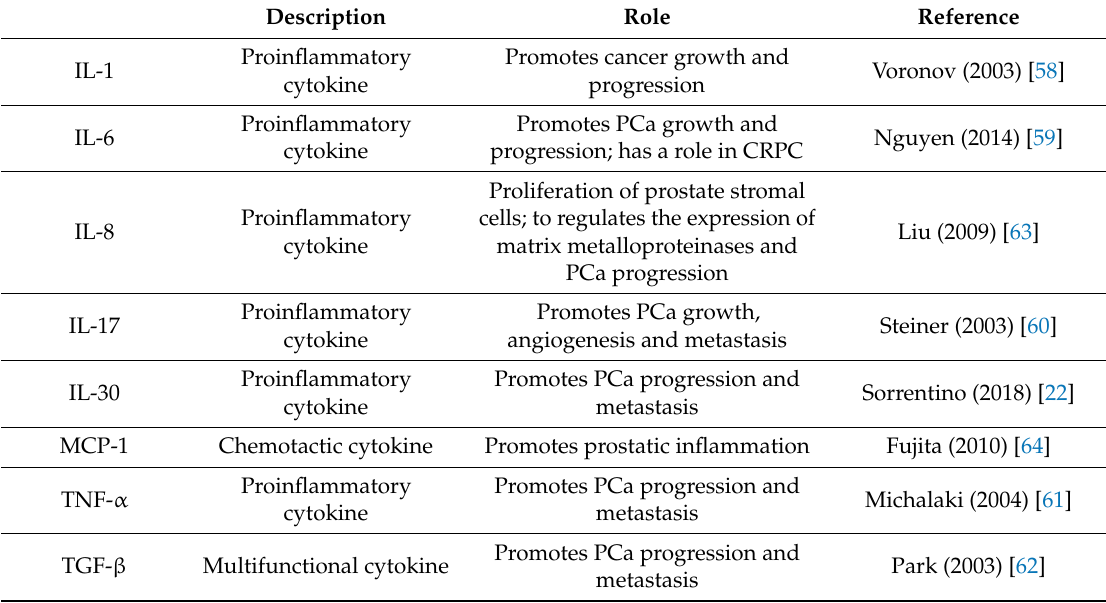
Table 1. Circulating and in situ inflammatory factors detected in PCa patients (PCa: Prostate Cancer). Description Role